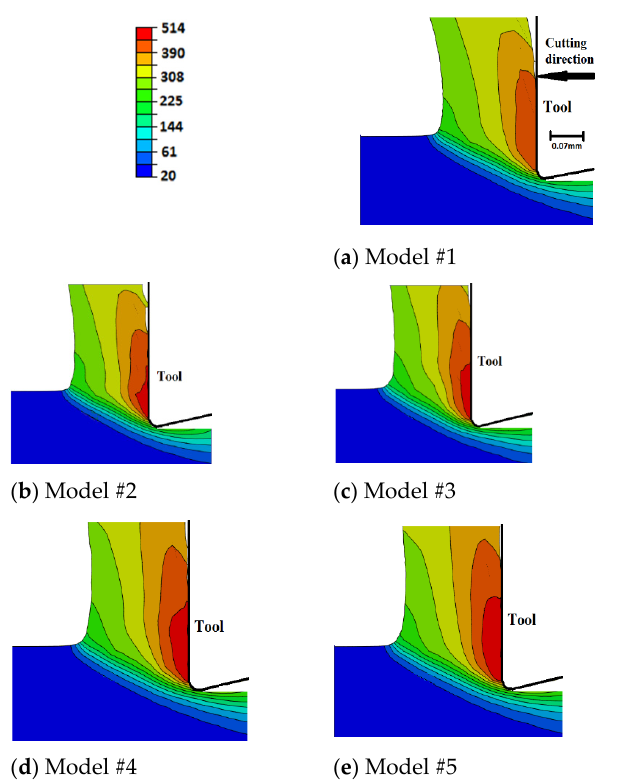
Figure 9. Workpiece temperature (°C) distribution within the chip formation zone—honed tool.